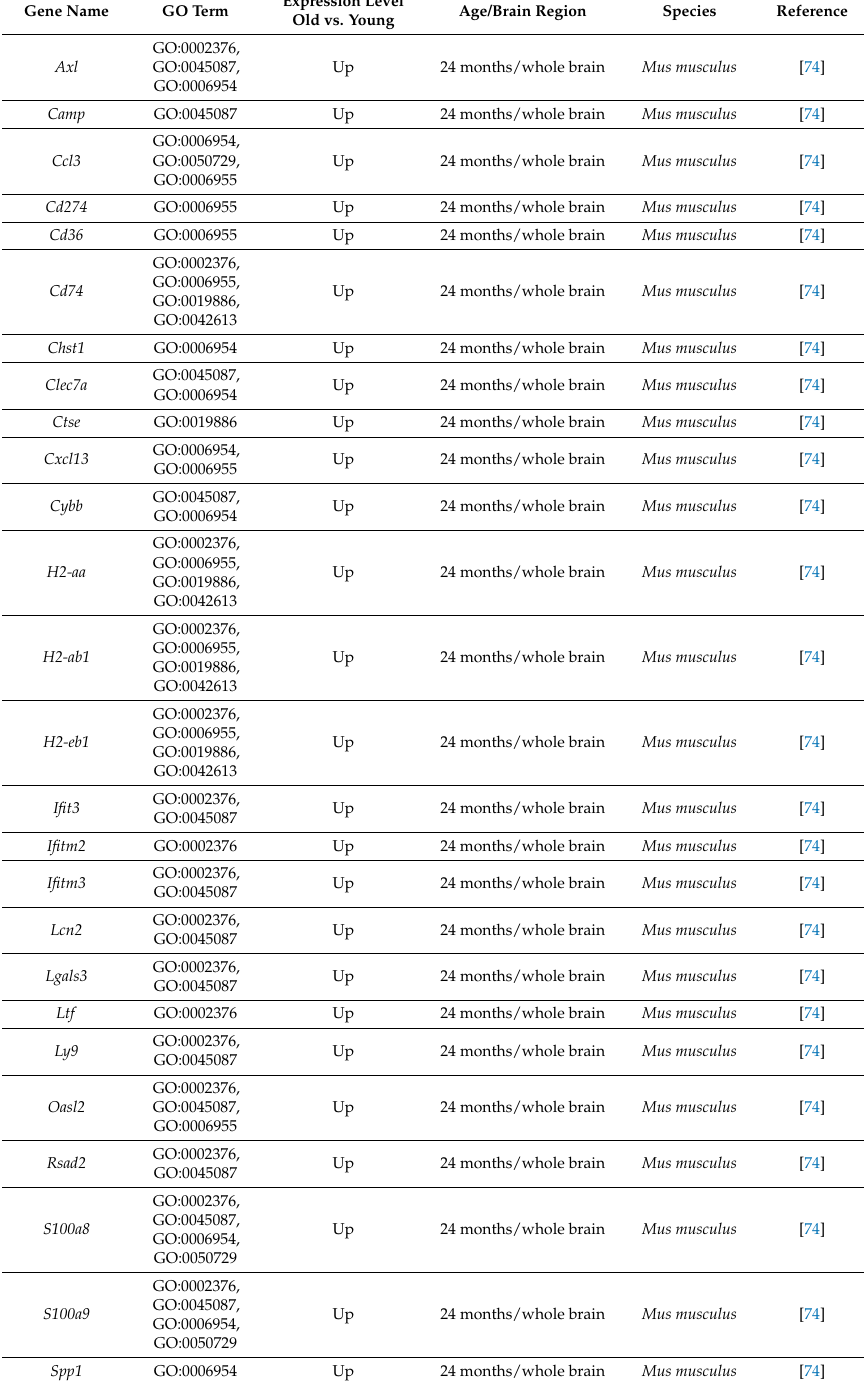
Table 1. List of differentially expressed genes (DEGs) associated with inflammation/immune response in aged